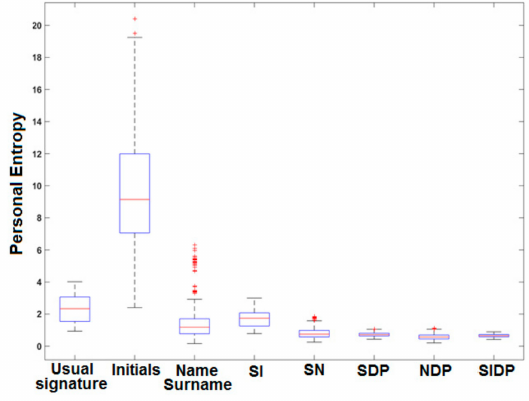
Figure 15. Boxplots of PE values per signature type for users of the lowest PE category.